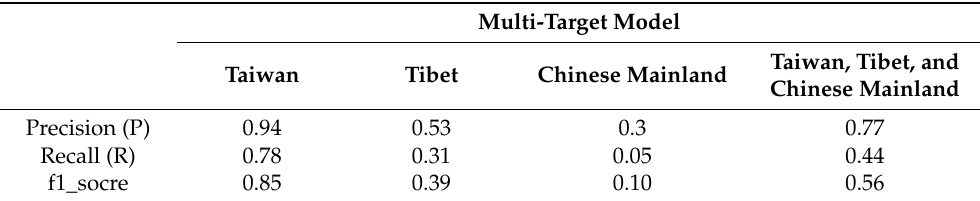
Table 4. Accuracy statistics of different targets with the multi-target detection